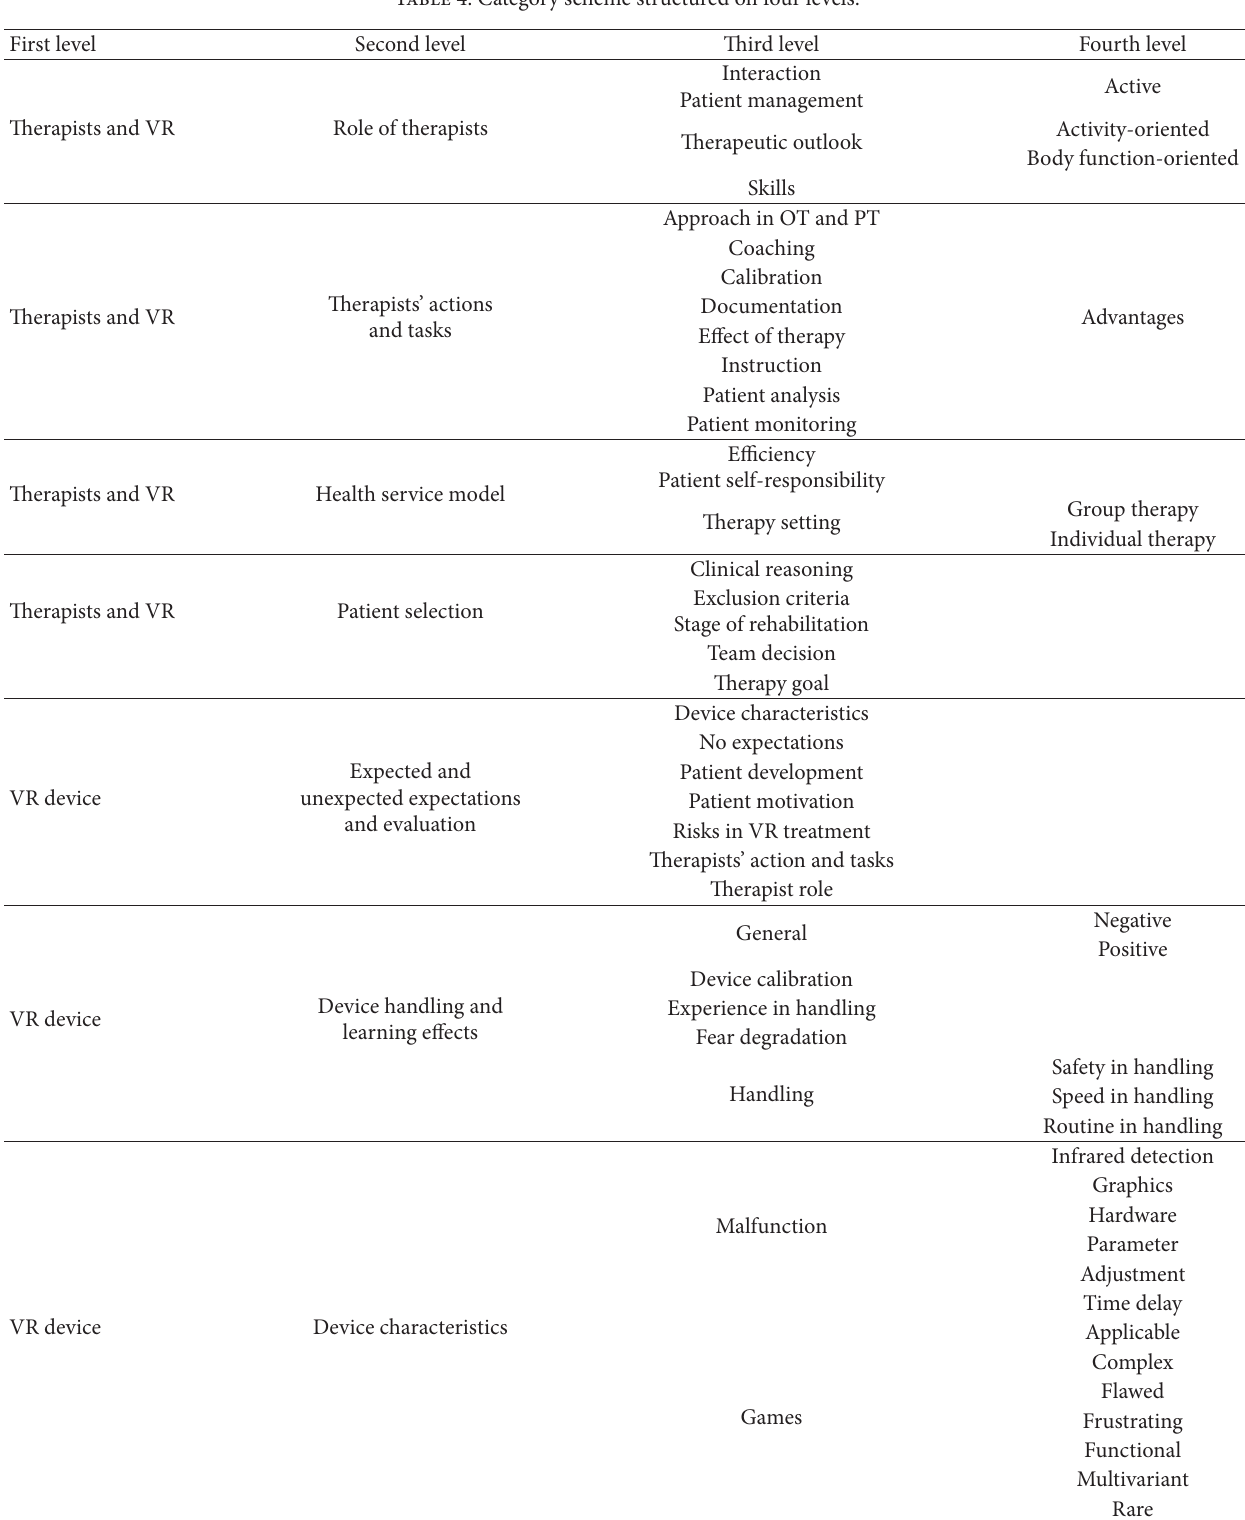
Table 4: Category scheme structured on four